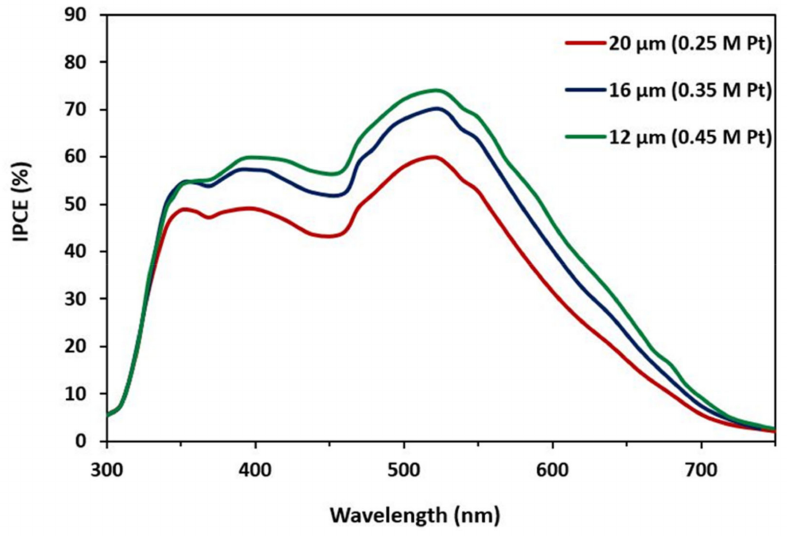
Figure 12. IPCE spectra at three different thicknesses and molar